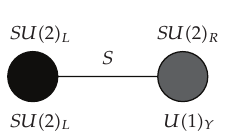
Figure 2: Diagram of the 2-site model, the electroweak chiral